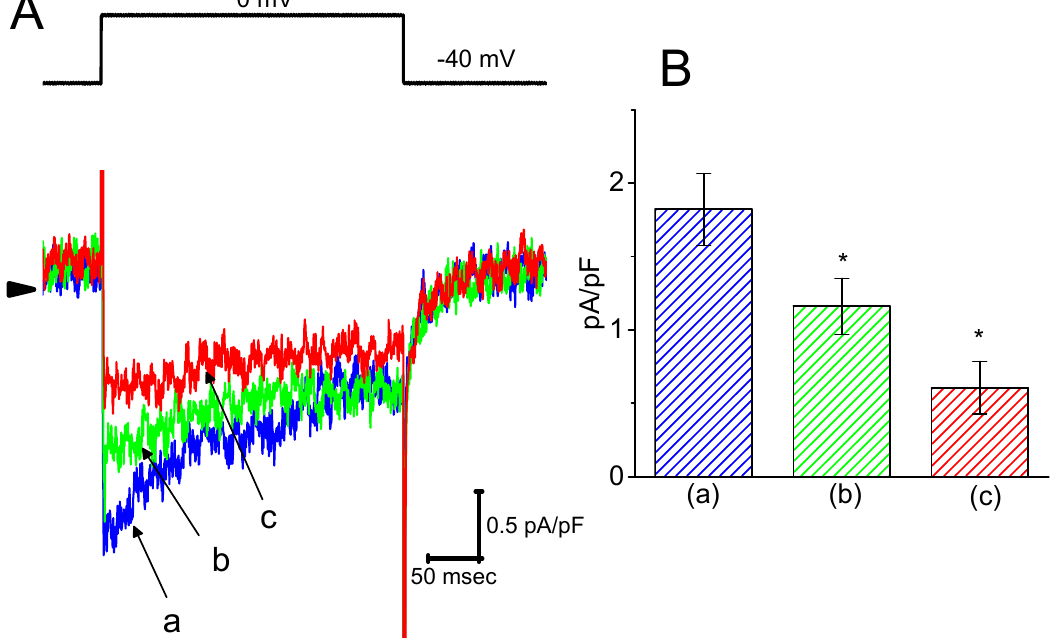
Figure 7. The inhibitory e ff ect of HBA on ICa,L density in GH3 cells. In this set of experiments, cells were immersed in normal Tyrode’s solution containing 1.8 mM CaCl 2 , 1 µ M tetrodotoxin, and 10 mM tetraethylammonium chloride, the composition of which is described in the Materials and Methods Section. The recording pipette was filled with a Cs + -containing solution. ( A ) Original traces of I Ca,L density were elicited by membrane depolarization (indicated in the upper part). The arrowhead shows the zero current level. (a) control; (b) 3 µ M HBA; and (c) 10 µ M HBA. ( B ) Summary bar graph showing the e ff ect of HBA on the peak density of I Ca,L (mean ± SEM; n = 12 for each bar). The current density was measured at the beginning of each brief depolarizing pulse from − 40 to 0 mV. (a) control; (b) 3 µ M HBA; (c) 10 µ M HBA. * p < 0.05 vs. the control.